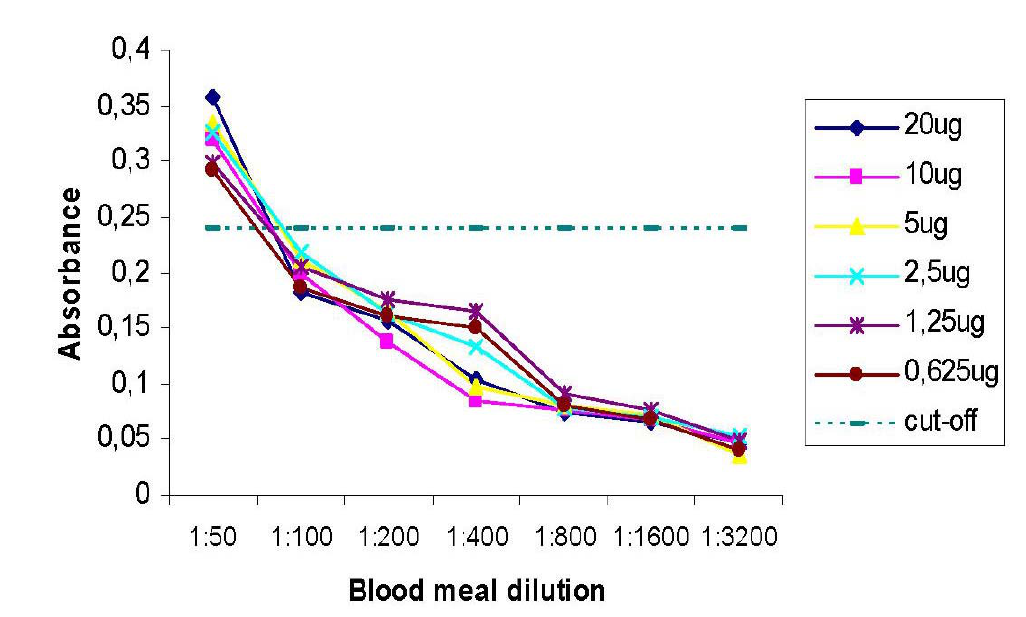
Figure 2. Optimization of the biotin/avidin ELISA assay for identifying rat blood meal dilutions for Culex quinquefasciatus